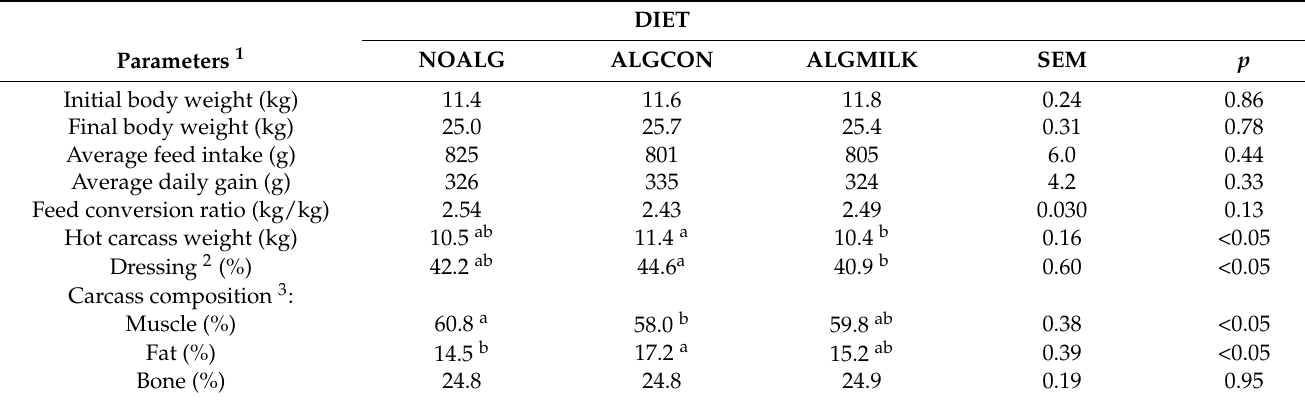
Table 1. Growth performance and carcass characteristics of feedlot lambs fed a conventional diet alone (NOALG) or feedlot lambs with competent reticular groove reflex fed the same diet supplemented with 2.5% of algae meal, either mixed in the concentrate (ALGCON) or in the milk replacer